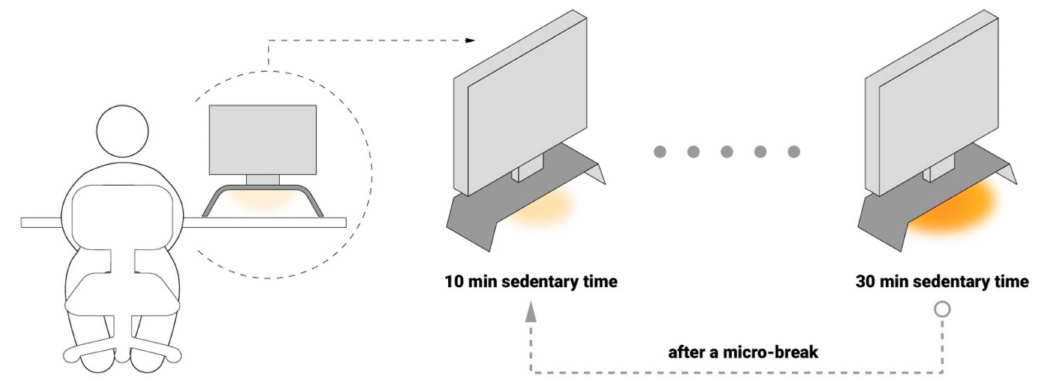
Figure 5. The working mechanism of LightSit as a peripheral intervention.